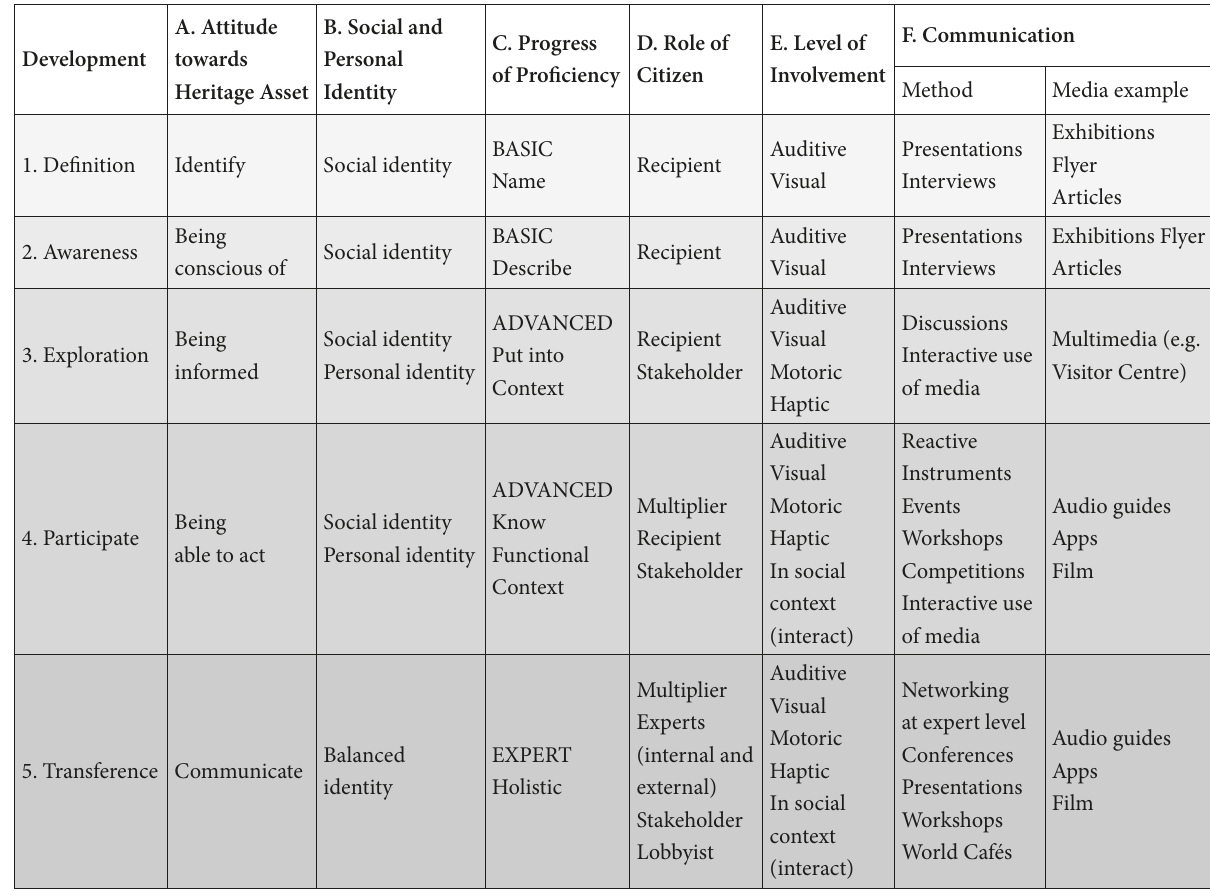
Table 1 The Communication Model for Built Heritage Assets